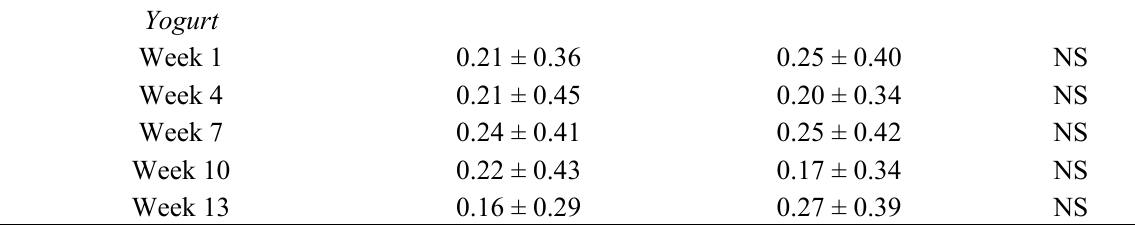
eggs; RTE Cereal = 3/4 cup; Hot Cereal = 3/4 cup; Pancakes = 2 small pancakes; Breakfast Meats = 1.5 ounces; Potatoes = 4 ounces; Toast = 2 slices or 1 bagel; Pastries = 2 small; Juice = 8 ounces; Milk = 8